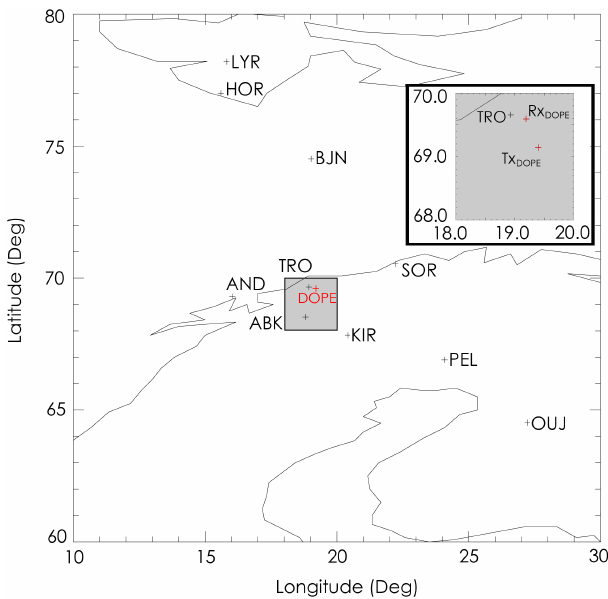
Fig. 1. The locations of the ground based instrumentation used dur- ing this study. The red crosses represent the locations of the DOPE (Doppler Pulsation Experiment) sounder and the black crosses rep- resent the locations of the ten IMAGE magnetometer stations used in this study. The grey shaded square shows a zoomed in view of the DOPE site highlighting both the location of the transmitter (Tx) and Receiver (Rx) sites relative to the IMAGE magnetometer at Tromsø